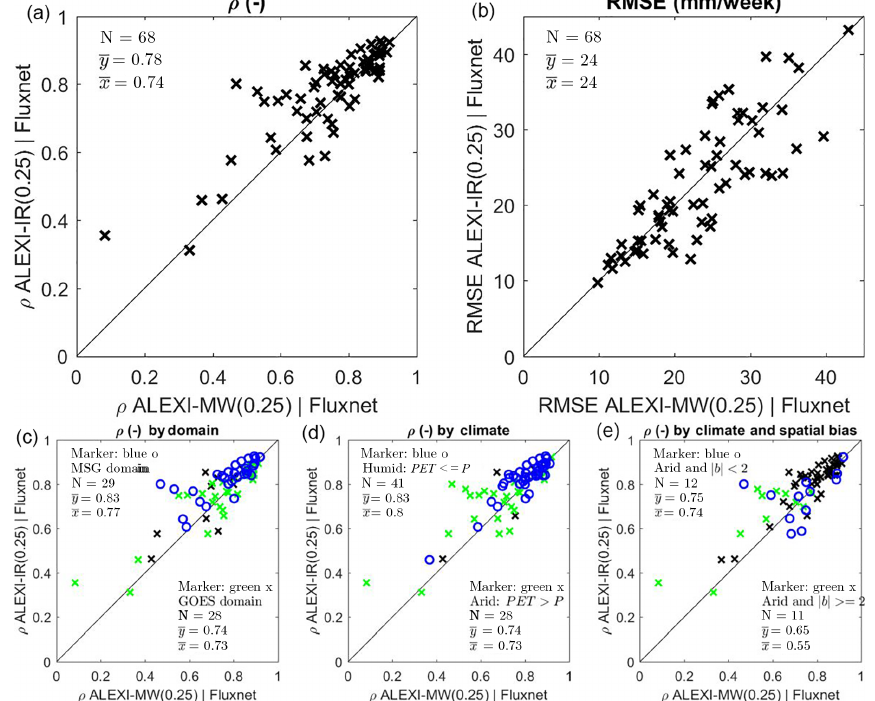
Figure 11. The effect of switching from TIR to MW-LST as input to ALEXI on Pearson correlation ( ρ ) and RMSE between weekly ALEXI ET estimates and flux-tower eddy-covariance measurements (Fluxnet). Each marker represents a single station and compares results calculated for ALEXI-MW ( x axis) with those calculated for ALEXI-IR ( y axis). (c) - (e) Same data as presented in (a) , but now distinct subsets of the tower sites are emphasized. (c) Sites by geographic region; (d) sites grouped by climate (humid vs. arid, see text for definition). (e) splits the arid sites further based on bias between the ALEXI-IR (0.05 ◦ ) and the mean value for the encompassing 0.25 ◦ grid box with a threshold of | b |= 2mmweek − 1 . The black x mark stations that are either below 60 ◦ N or are not covered by the two contrasting